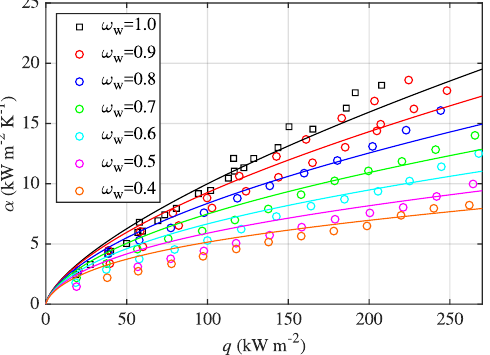
Figure 10. Measured data compared with the Schlünder correlation (solid lines) evaluated with coefficients C 0 = 1 and β L = 2 × 10 − 4 ms − 1